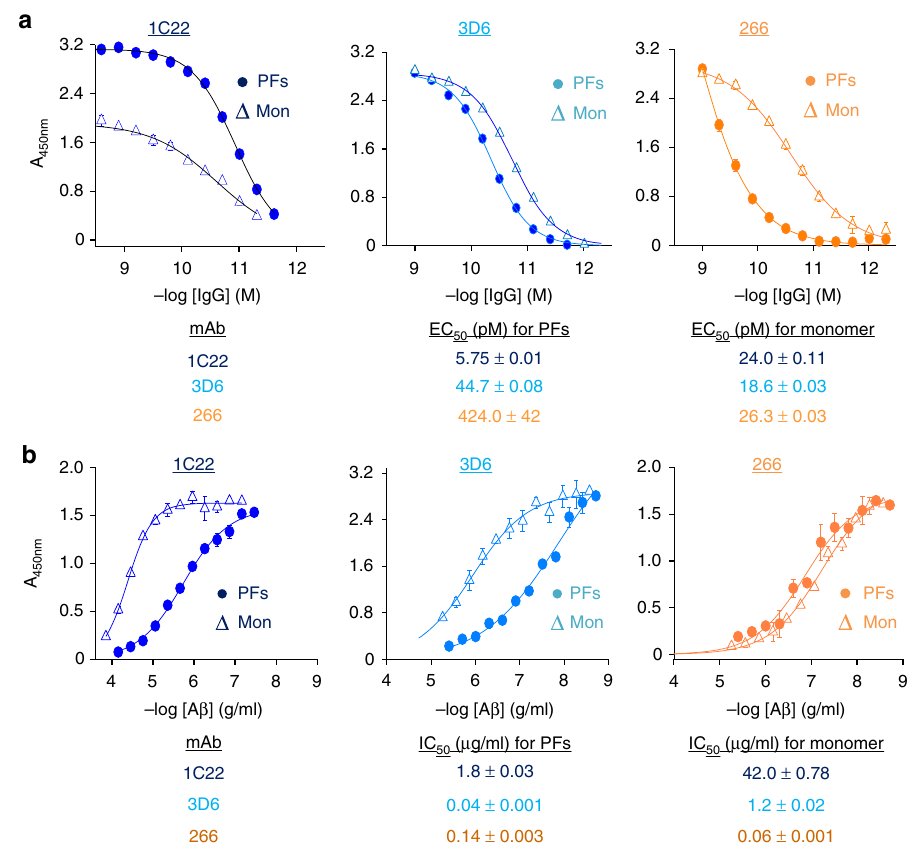
Fig. 1 MAb 1C22 binds to PFs better than monomer. a A β 1-40 monomer (Mon) and [A β 1-40S26C] 2 proto fi brils (PFs) were immobilized at 200 ng/well on microtiter plates and mAbs 1C22, 3D6 and 266 diluted across the plates. Antibody binding curves were sigmoidally fi t and used to determine the concentration of antibody that gave half-maximal binding EC 50 . Values in the table are in pM. b A β competition curves for mAbs binding to plate- immobilized A β monomers in the presence or absence of solution-phase Mon or PFs competitors were sigmoidally fi t and used to determine the concentration of competitor that produced half-maximal inhibition of mAb binding (IC 50 ). Values in the table are in μ g/ml. In both a and b values are the average±SD of each condition analyzed in triplicate. When error bars are not visible they are smaller than the size of the symbol. Because we do not know the molecular weight of proto fi brils the concentration of A β is given in μ g/ml. In contrast, since the molecular weight of IgG is known, we provided mAb concentration in molar amounts. All A β concentrations are based on monomer molar equivalents and results are representative of at least 3